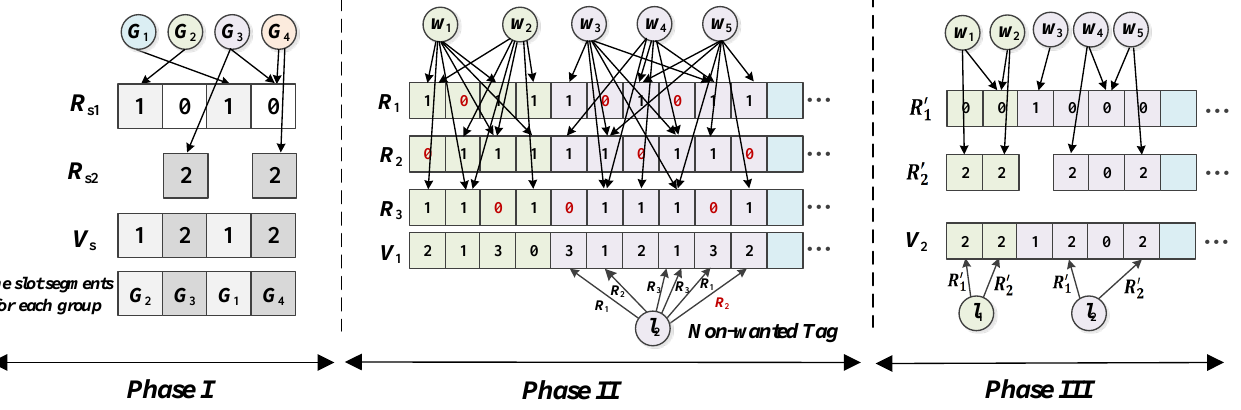
Figure 3. Illustration of the G-Search tag searching